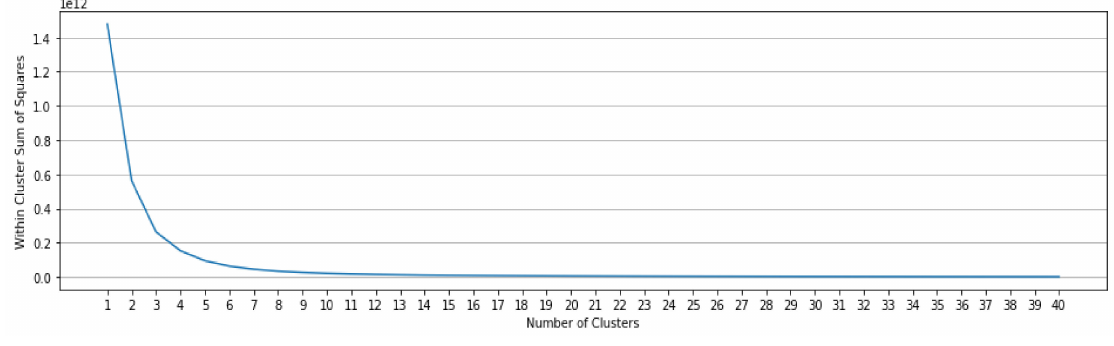
Figure 4. K-Means